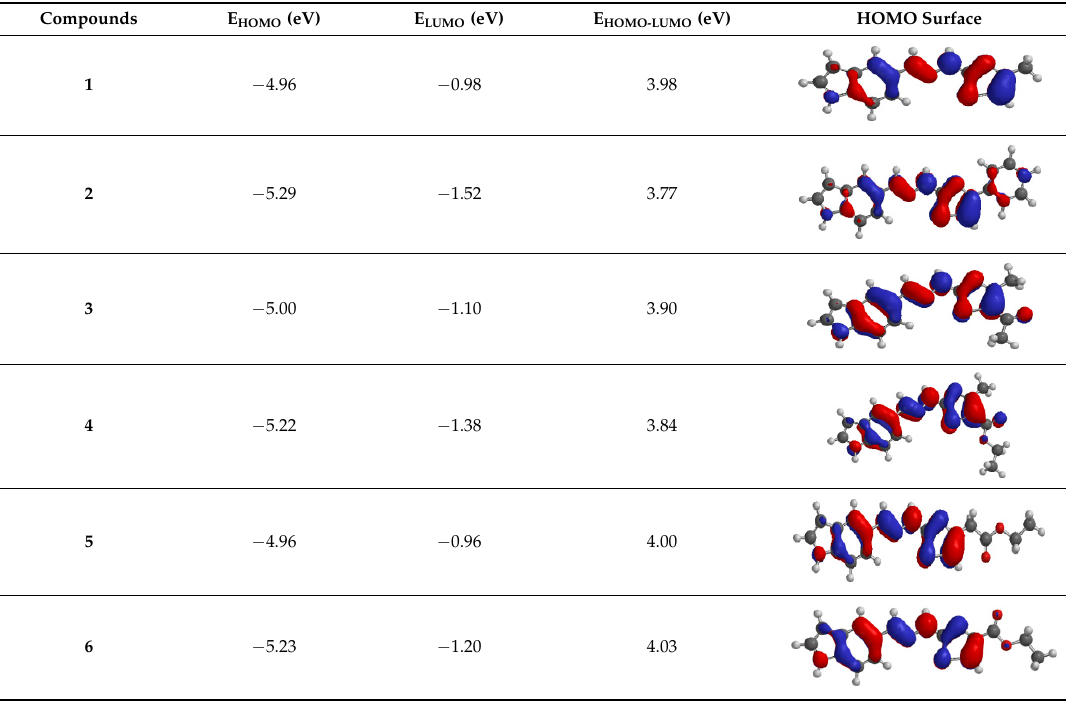
Table 2. Quantum molecular parameter and frontier orbital density distribution for indolyl-hydrazinylthiazoles 1 – 6 .